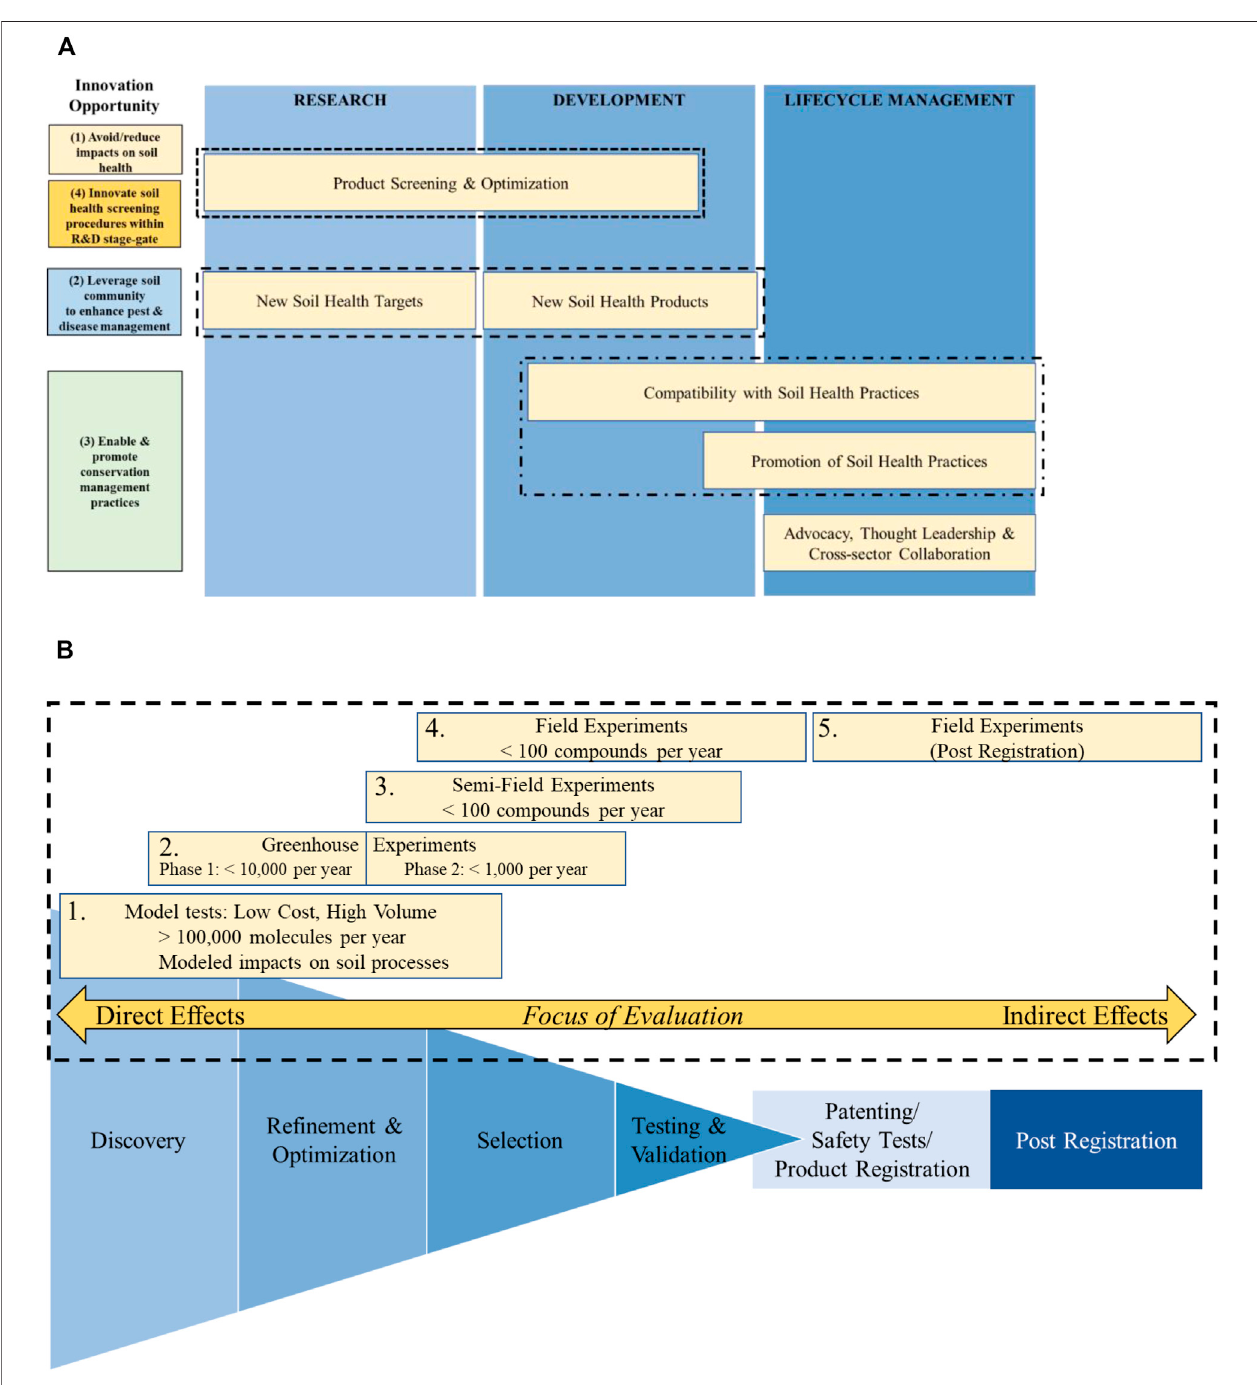
FIGURE 2 | Schematic of (A) major activities supporting innovation opportunities along the crop protection research and development (R&D) and lifecycle managementtimelinesand (B) R&Dpipeline withopportunitiestoscreenforsoil healthimpacts highlightedwithdashed (---)box. Thefocusofthesoilhealthevaluations will phase from potential direct effects of compounds on soil functions or soil health parameters in the early stages to indirect effects of compounds on soil health in later stages. Number of compounds evaluated in each phase is aspirational and may not re fl ect actual number of compounds currently undergoing evaluation.